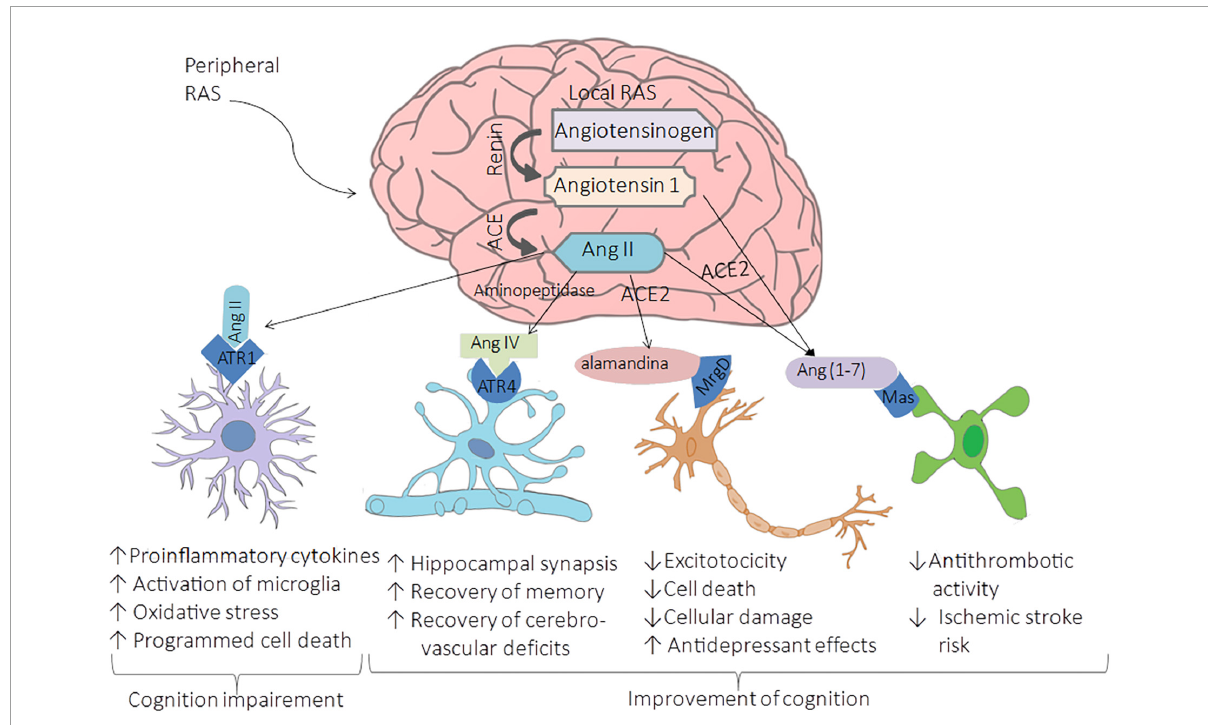
FIGURE1 Renin-Angiotensin-System in the brain. The cleavage of cerebral angiotensinogen produces four main neuroactive peptides: Ang II, Ang IV, Ang-(1-7), and alamandine. The upregulation of ACE leads to the hyperactivation of AT1R by Ang II conducing to brain vasoconstriction associated with cognitive impairment, cell death, and inflammation. In contrast, the binding of Ang II to AT2R, the bind of Ang IV, Ang-(1-7), and alamandine to AT4R, MasR, and MrgDR respectively, are related to enhancing cognition, synaptic remodeling, cell survival, cell signal transmission, and antioxidant/anti-inflammatory mechanisms leading to improvement of